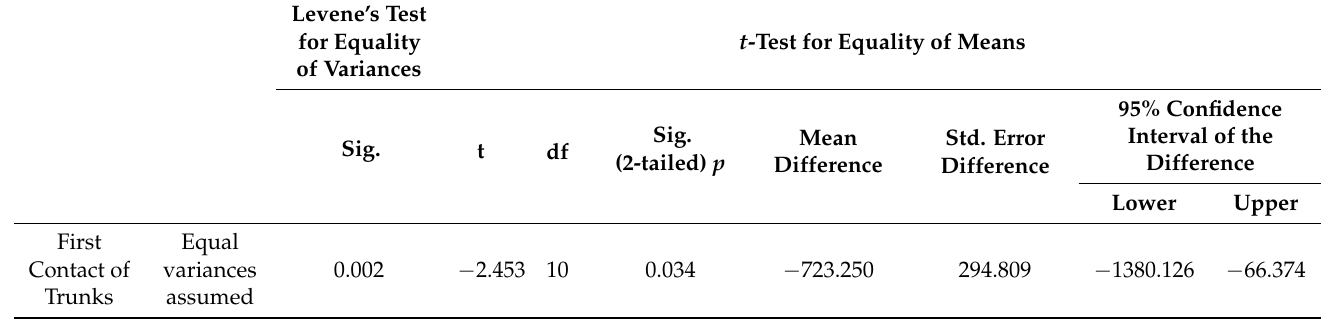
Table 8. Significances for related and unrelated elephants on first contact of trunks during